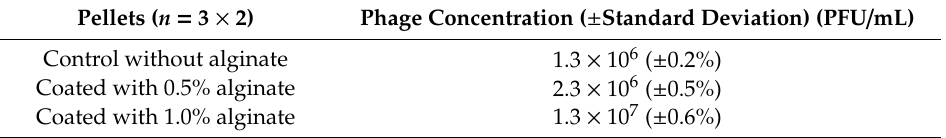
Table 1. Titration of phages retained on β -TCP ceramic pellets after 3 h of lysogenic broth (LB) washing. Pellets ( n = 3 × 2) Phage Concentration ( ± Standard Deviation) (PFU /